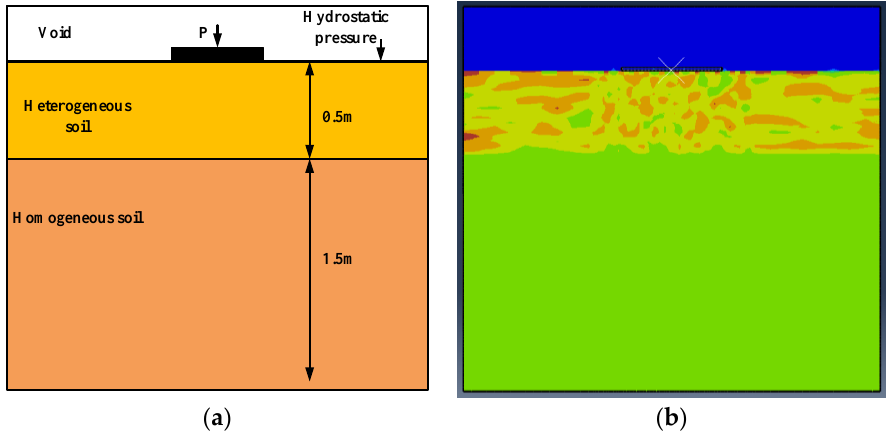
Figure 32. ( a ) The soil material distribution and ( b ) the density distribution.